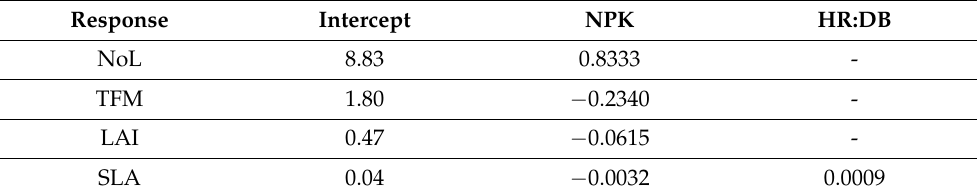
Table 7. Effect sizes for significant